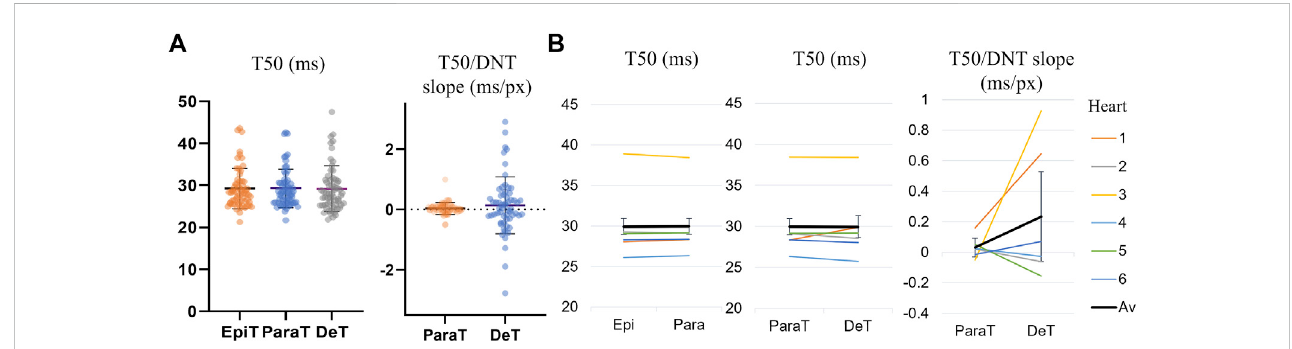
FIGURE 7 Transient T50 and T50/DNT slope for different DNT regions. (A) Transient T50 distributions, with each datapoint corresponding to the median T50 (ms) across all pixels within epitubular (EpiT, DNT = 0), paratubular (ParaT, 0 < DNT ≤ 5) or detubulated (DeT, DNT > 5) regions. The horizontal lines indicate the mean ± SD over all cells ( n = 60). None of the differences were statistically signi fi cant. (B) Transient T50/DNT slope in different regions of each cell, averaged over the cells from each heart (1 – 6, see legend). The overall average ( “ Av ” ) across the six hearts is shown in black. The error bars represent the standard errors (SE = SD/ √ n) across the heart averages. When comparing cell-by-cell differences, averaged for each heart using a one-sample t -test, there was no signi fi cant difference in T50 and T50/DNT slopes in parts of the cell corresponding to the various DNT categories.